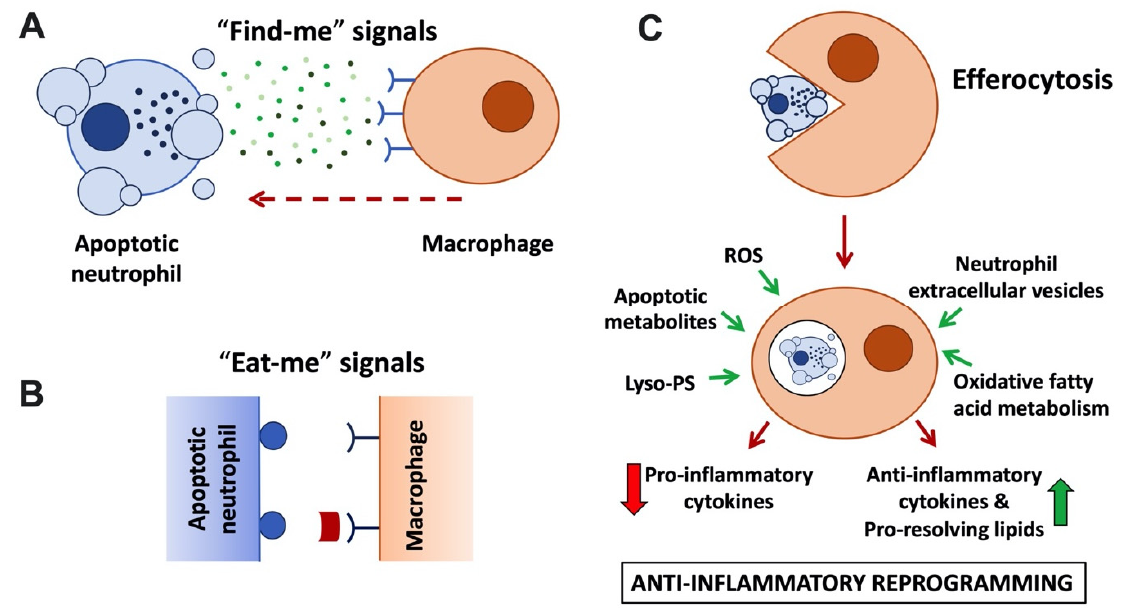
Figure 2. Anti-inflammatory neutrophil functions linked to apoptosis and efferocytosis. ( A )